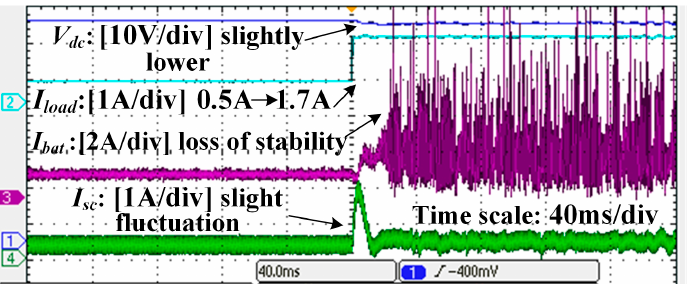
Figure 18. Control parameters of Group F: DC bus voltage, CPL current, battery current and SC current of a DC microgrid.